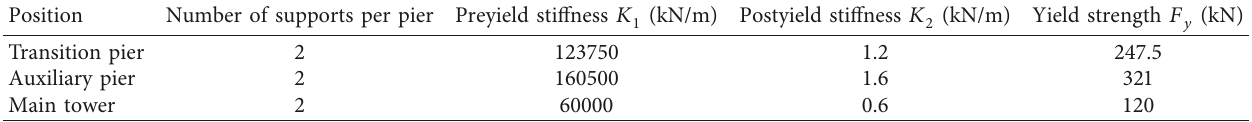
Figure 10: Friction slip hysteresis model of the movable support. Table 3: Dynamic parameters of the movable support.